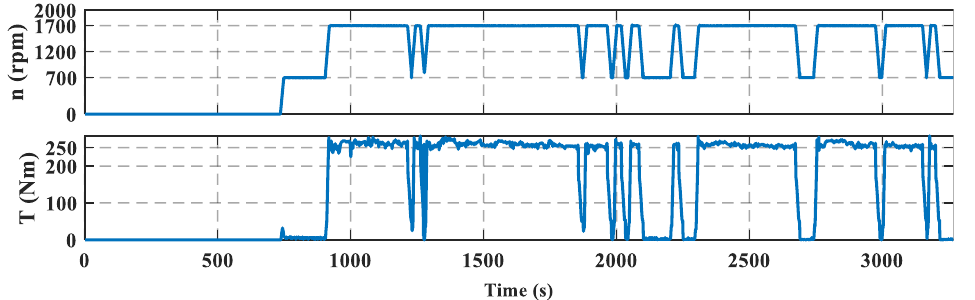
Figure 5. Operating states of the working motor.